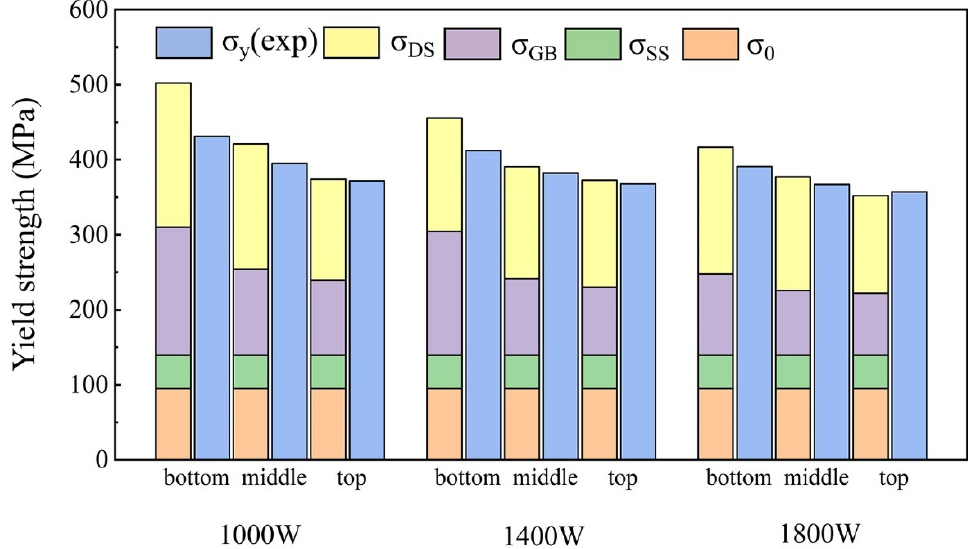
Figure 13. Comparison of theoretical calculations and experimental measurements of yield strength of Al 0.5 FeCoCrNi HEA manufactured by LMD.